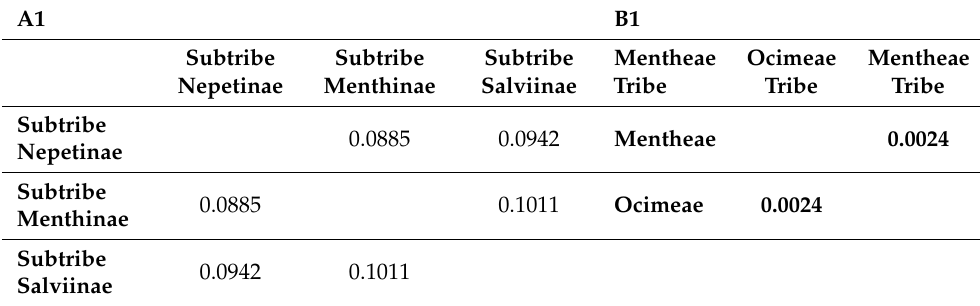
Table 5. Pairwise of one-way PERMANOVA test on the EOs of Subtribes ( A1 ) and Tribes ( B1 ).